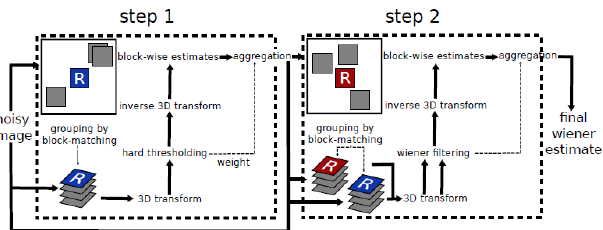
Figure 1. Scheme of the BM3D algorithm. (Lebrun